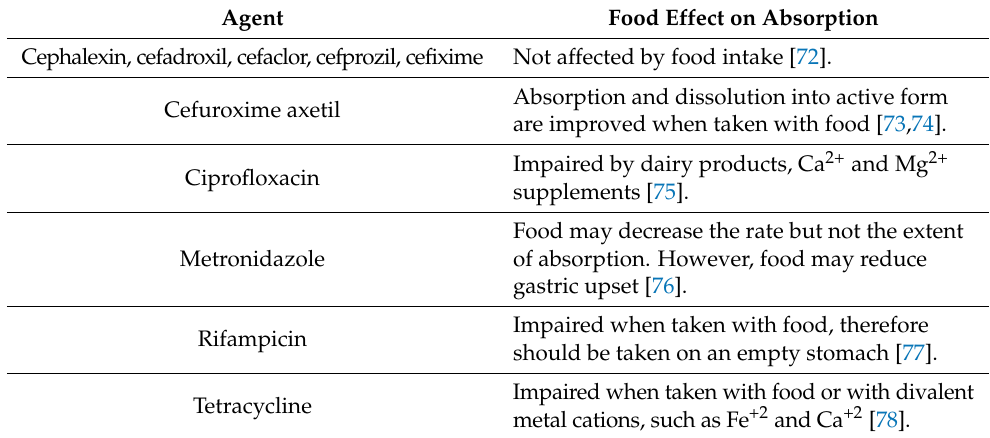
Table 2. Cont. Agent Food Effect on Absorption Cephalexin, cefadroxil, cefaclor, cefprozil, cefixime Not affected by food intake [72]. Absorption and dissolution into active form Cefuroxime axetil Ciprofloxacin